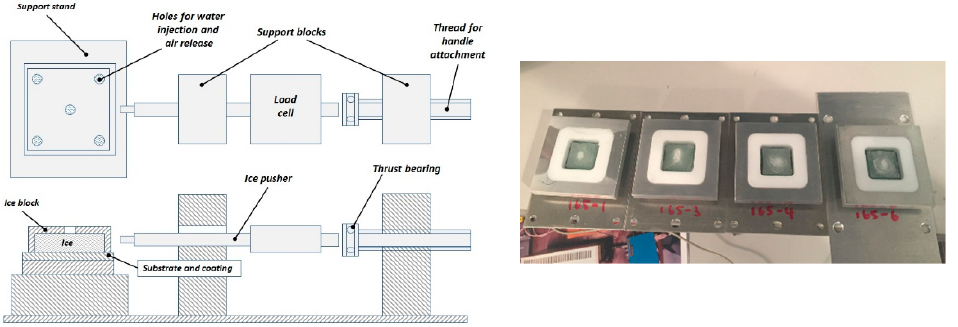
Figure 1. Schematic drawings of the push rig for ice adhesion test ( left ) and a picture of test specimens with ice formed in a cavity of PTFE-lined aluminum mold on top of coating surfaces ( Right ). 2.3. Preparation of Surface-Modifying Polymers (SMPs) and Durable Hydrophobic Polyurethane (SPU) Coatings